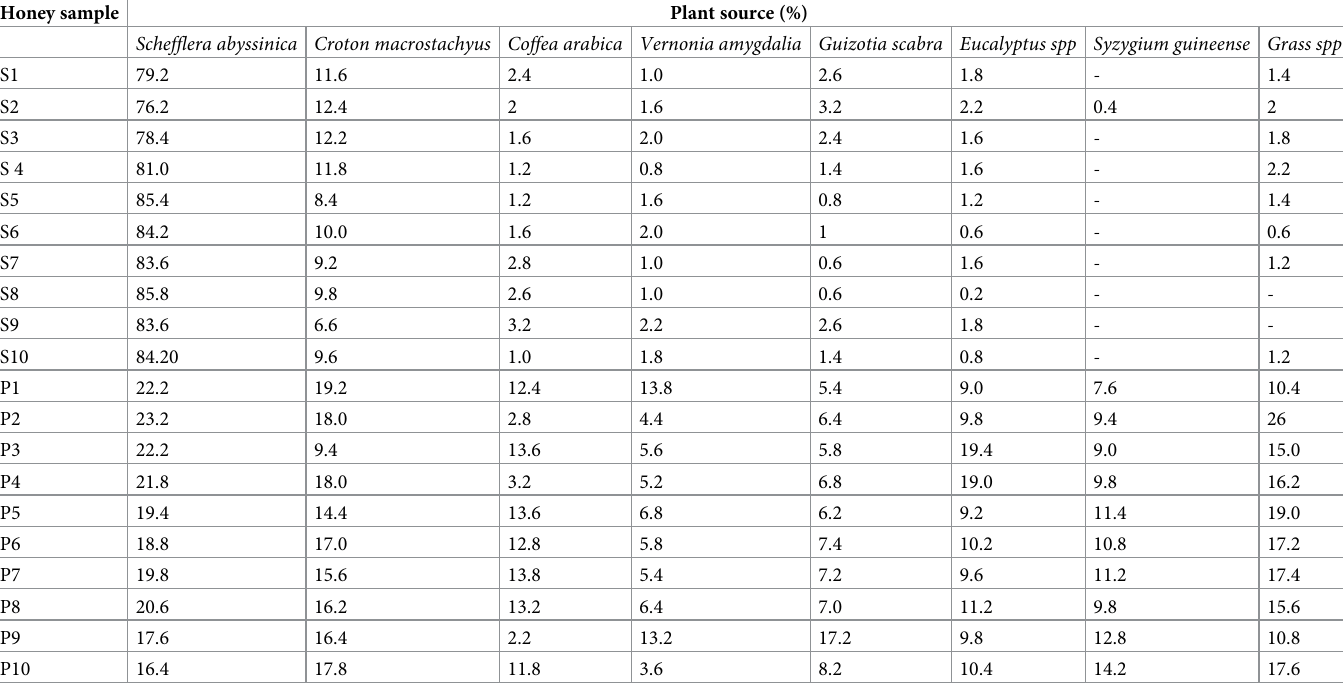
Table 1. Pollen count distribution for selected monofloral and polyfloral honey (n = 20). Honey sample Plant source